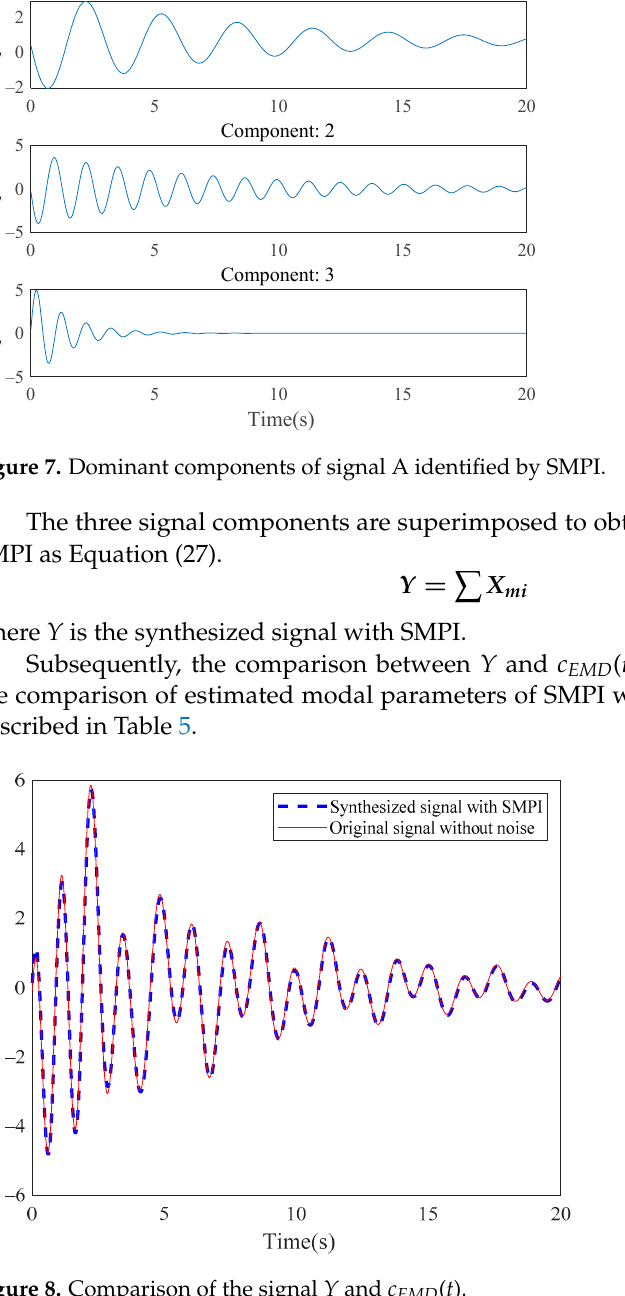
Figure 8. Comparison of the signal Y and c EMD ( t ). In light of Table 5, the value of estimated modal parameters is very close to that of true modal parameters, and the relative errors between them are comparatively small. The frequencies calculated by SMPI are all within 1% relative error. And the relative error of damping ratios and phase angles are less than 3% and 4%, respectively. As for the relative error of amplitude, the smallest is less than 0.1%, and the biggest one is not more than 4%. As Figure 8, the curve of signal Y synthesized with the identified results of SMPI is found in good coincidence with that of c EMD ( t ), whose dominant modal parameters have been extracted